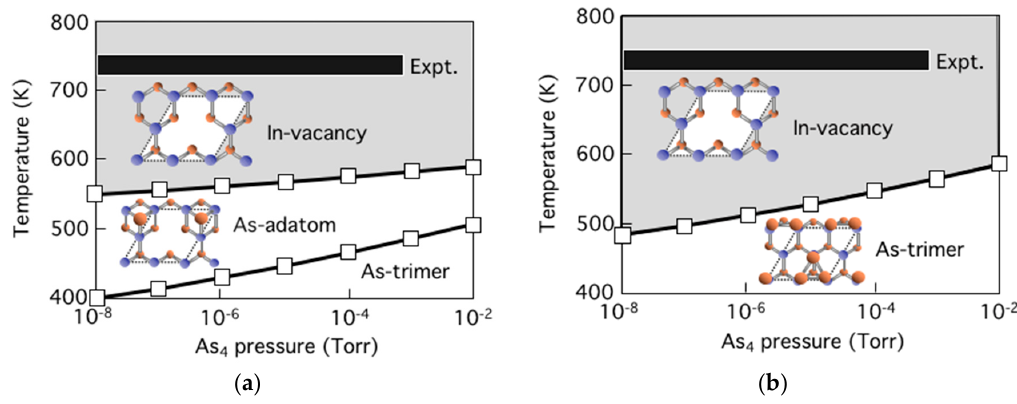
Figure 2. Calculated surface phase diagrams for ( a ) InAs(111)A WL surface and ( b ) fully relaxed surface without interface structure of InAs/GaAs as functions of temperature and BEP of As 4 . Black area denotes the temperature range of the conventional MBE growth.